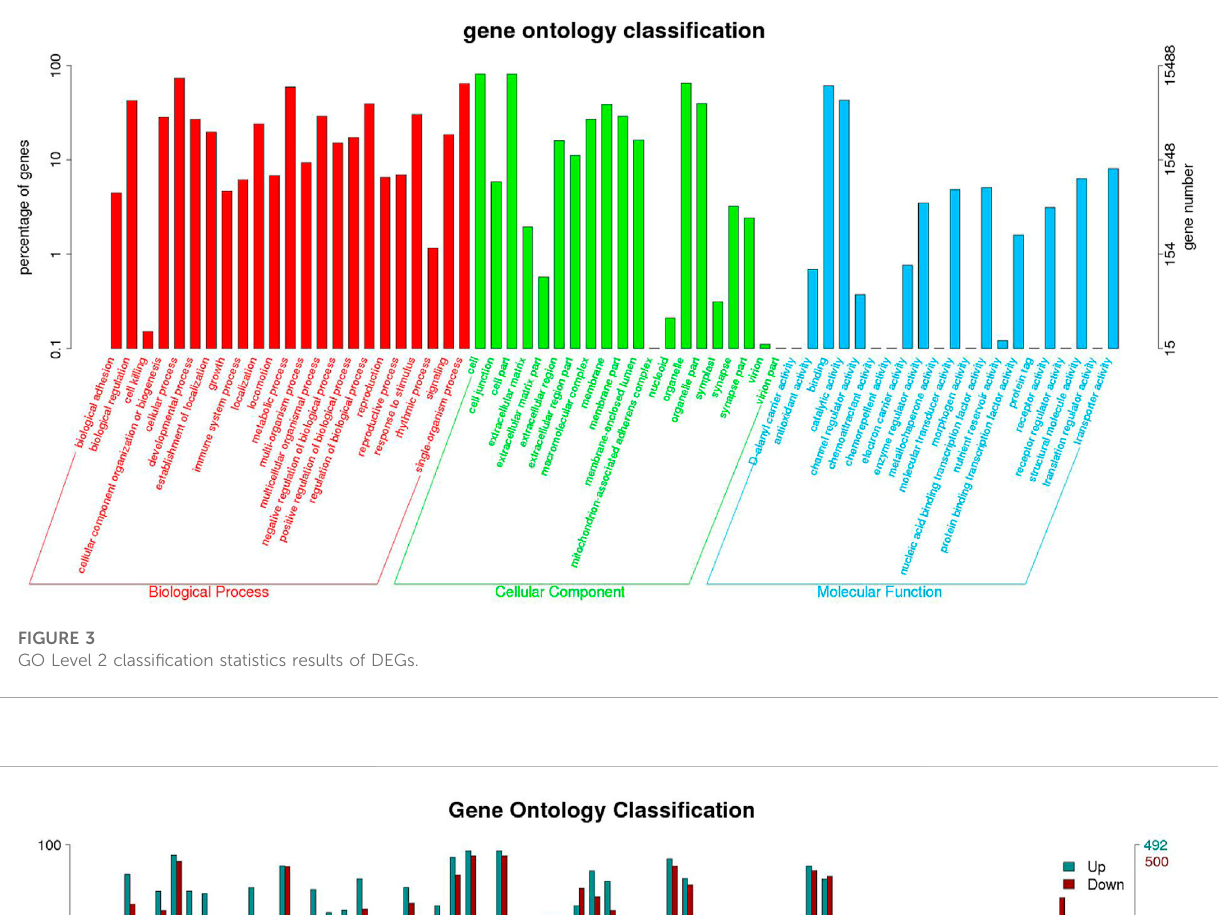
FIGURE 3 GO Level 2 classi fi cation statistics results of DEGs.